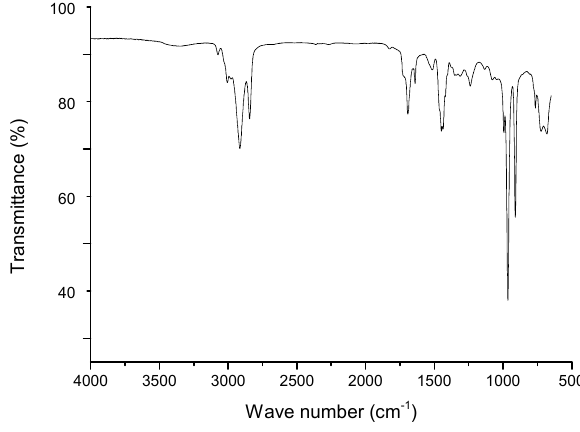
Figure 8. FT-IR spectra of the cured HTPB/HDI-trimer PU coating.